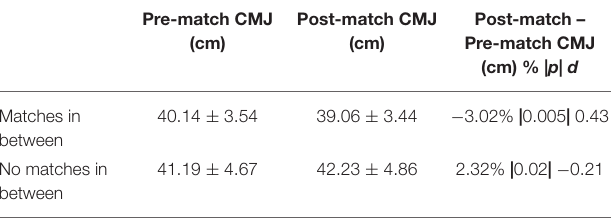
TABLE 2 | Descriptive statistics (mean ± SD) for the pre- and post-match countermovement jump (CMJ) (mean value) to those played and not played matches in